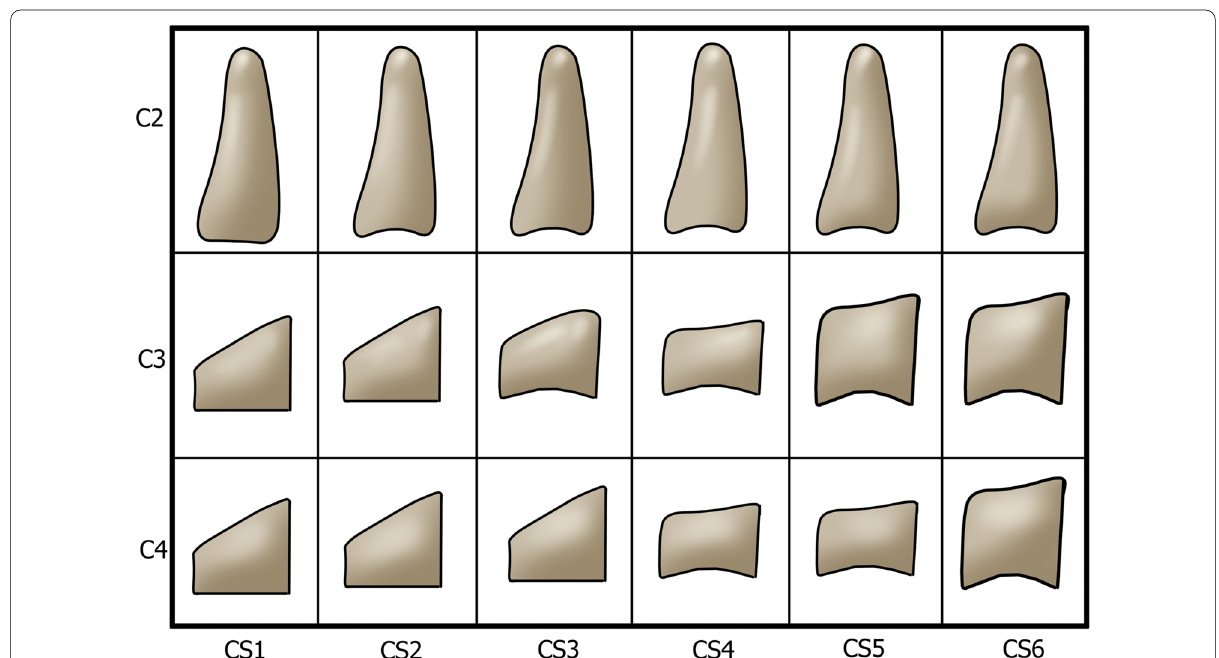
Fig. 1 Cervical vertebral maturation staging, introduced by Baccetti. CS1: three vertebrae have flat inferior borders, and C3 and C4 are trapezoids in shape. CS2: the inferior border of C2 is concaved. C3 and C4 are still trapezoidal. CS3: the inferior borders of C2 and C3 are concaved. The shape of C3 and C4 may be a trapezoid or horizontal rectangle. CS4: concavity is visible in the inferior border of three vertebrae. C3 and C4 are in the shape of a horizontal rectangle. CS5: concavity is visible in the inferior border of three vertebrae. C3 and C4 may be shaped like a square or a horizontal rectangle. CS6: concavity is visible in the inferior border of three vertebrae. C3 and C4 may be in a shape of a square or vertical